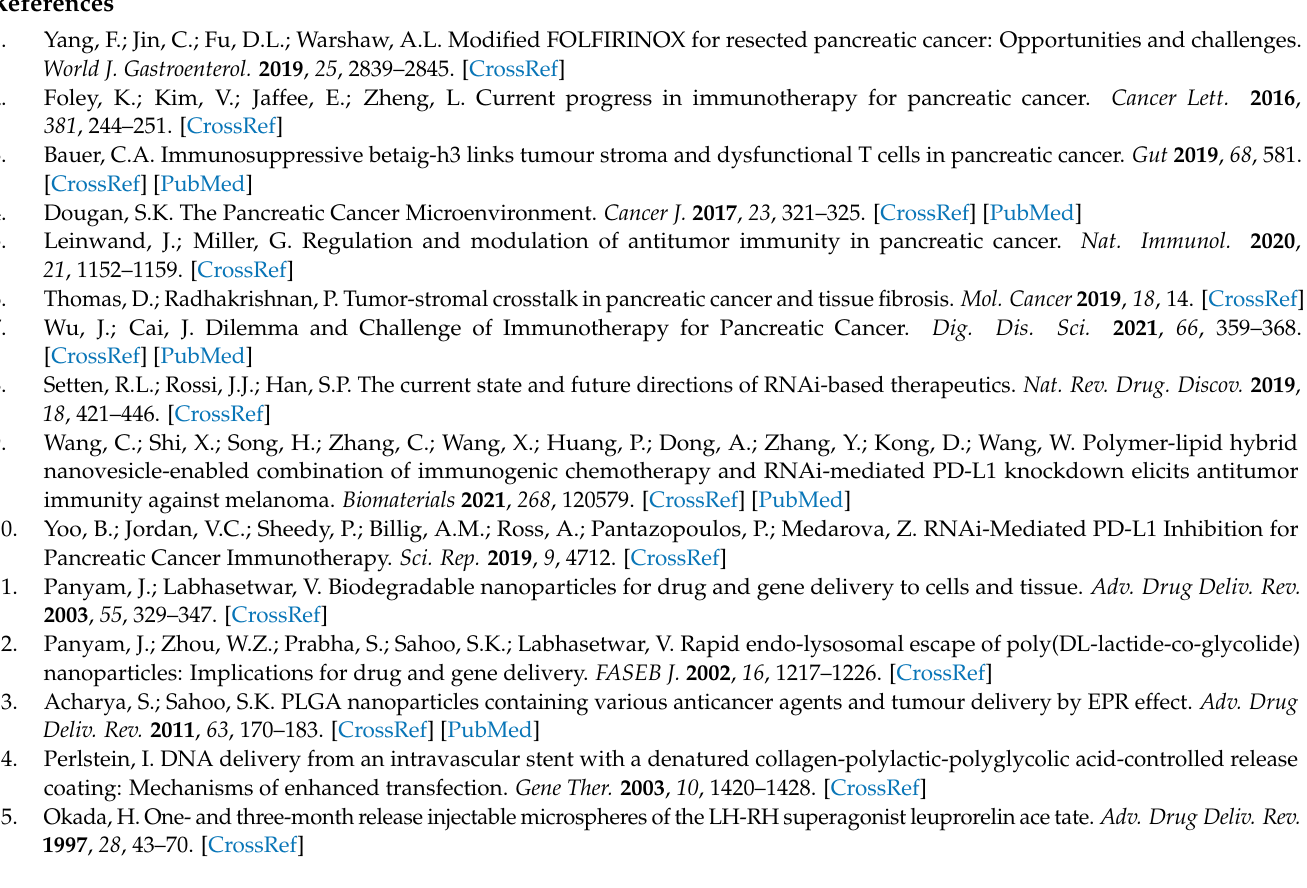
L1@PLGA-treated tumors. Figure S6: Ratio of infiltrated immune cells in the individual PDAC tumors. Supplementary Table S1: Density of immune cells in the blood of normal NSG and human- ized NSG